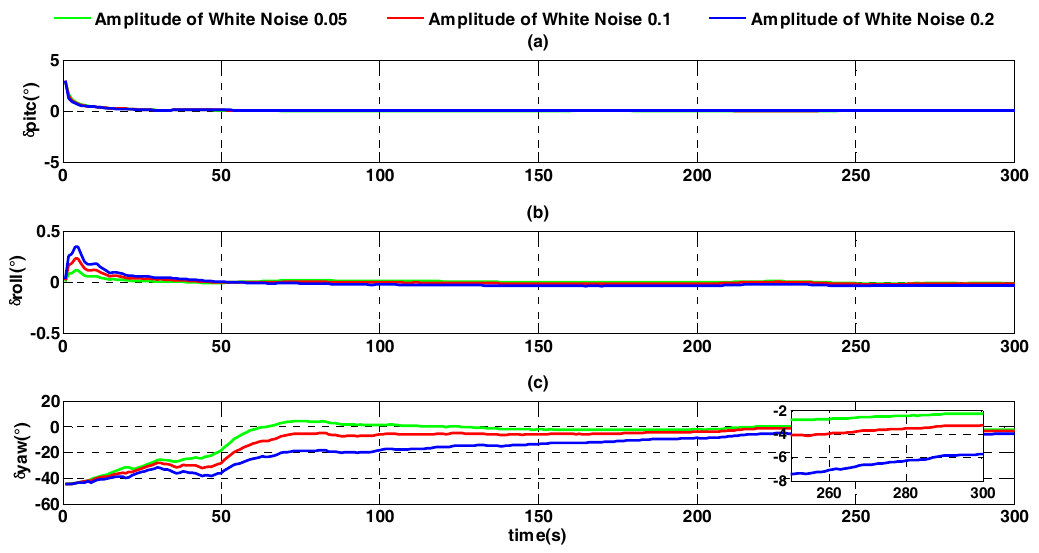
13 of 16 Figure 11. Alignment error curves of different constant errors. ( a ) The error curves of pitch angle; ( b ) the error curves of roll angle; ( c ) the error curves of heading angle. In Figure 11, it can be seen that, under conditions of different constant error of velocity, horizontal attitude error can converge fast, while the error of the heading angle increases with the